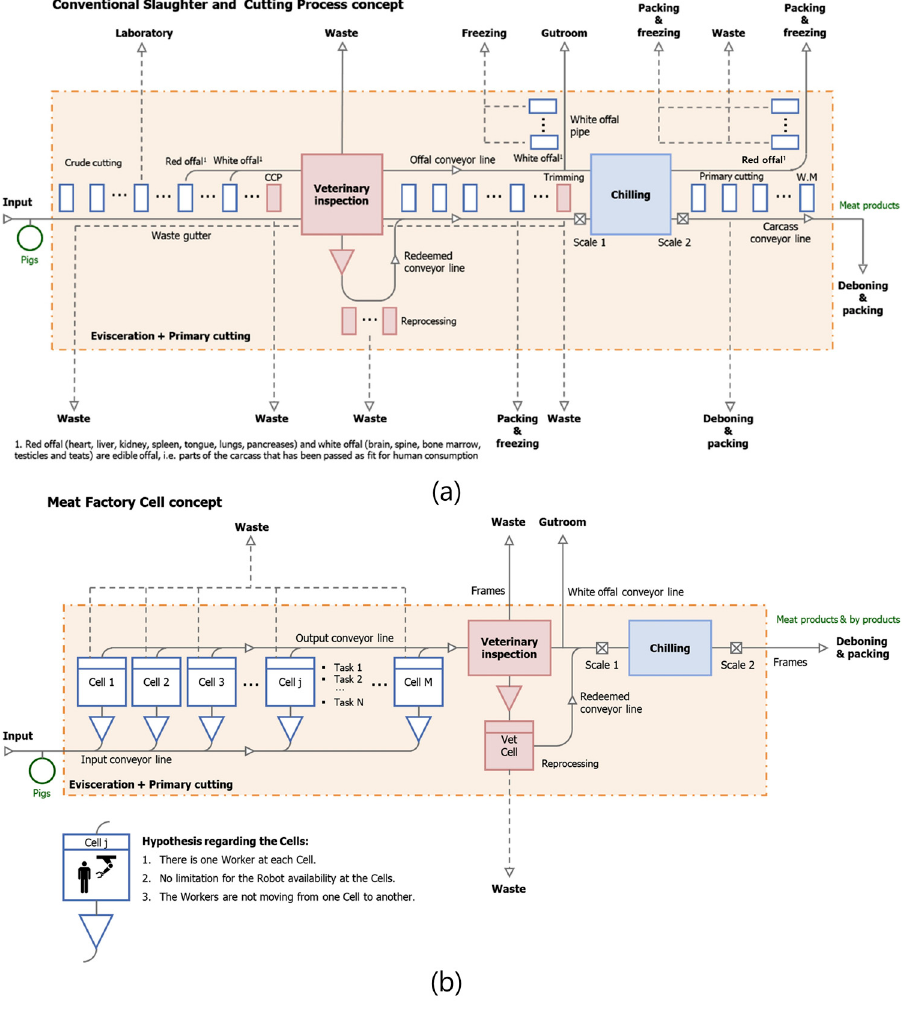
Figure 8. ( a ) A line style conventional meat processing line; ( b ) the meat factory cell processing concept [65,69] (from Valente et al. Life cycle sustainability assessment of a novel slaughter concept. Reprinted with permission of Elsevier, Amsterdam, Copyright © 2020).